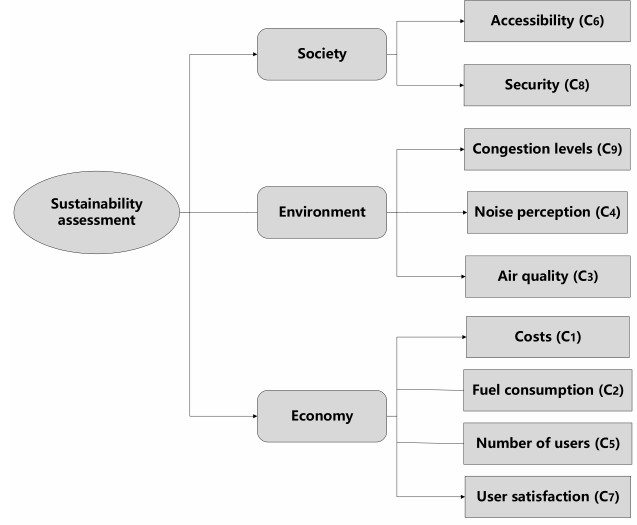
Figure 2. Evaluation criteria for sustainability